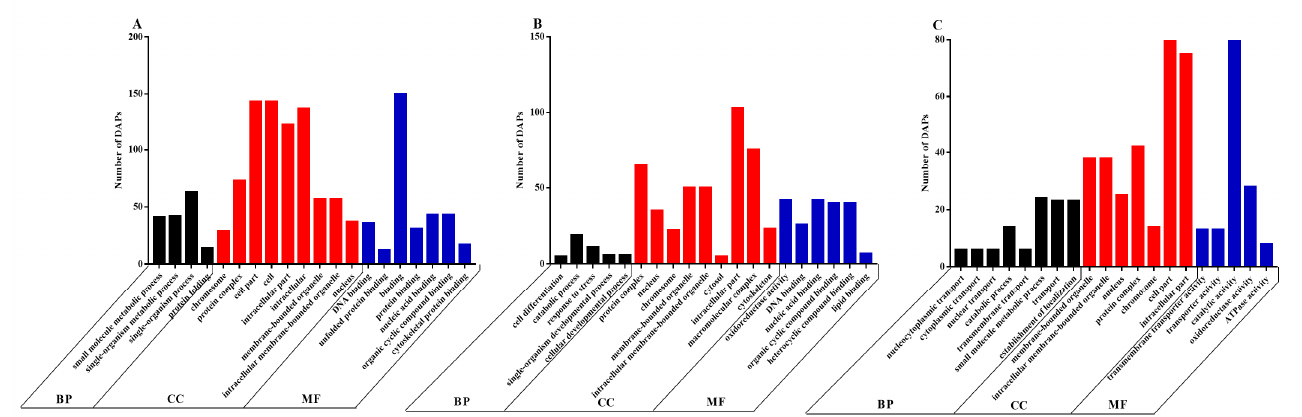
Figure 4. The 20 most enriched terms of differentially abundant proteins (DAPs) by Gene Ontology (GO) analysis between the CON and LP groups on days 0 ( A ), 5 ( B ) and 7 ( C ). BP, biological process; CC, cellular component; MF, molecular function. DAPs: differentially abundant proteins.